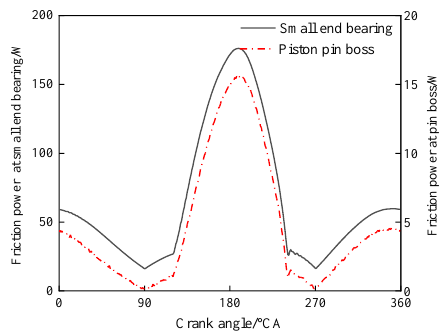
Figure 8. Friction power of bushing and piston pin boss.